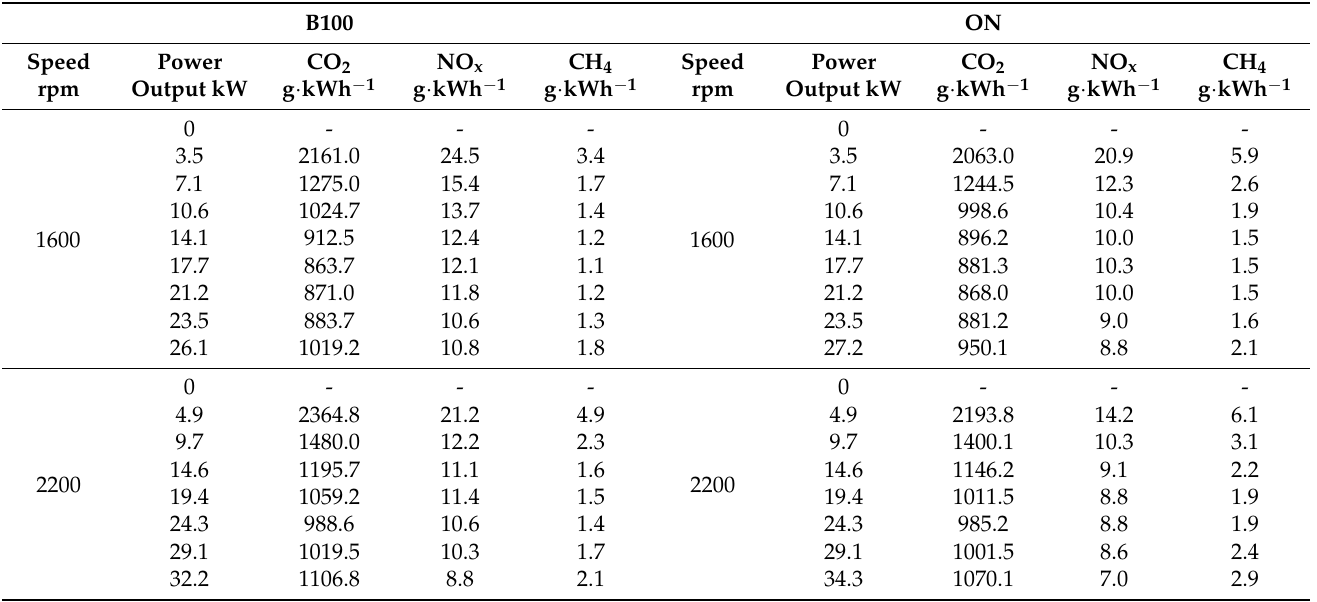
Table 8. Level of emissions of GHG components (g · kWh − 1 ) due to fuel and engine speed (rpm) and power output (kW).